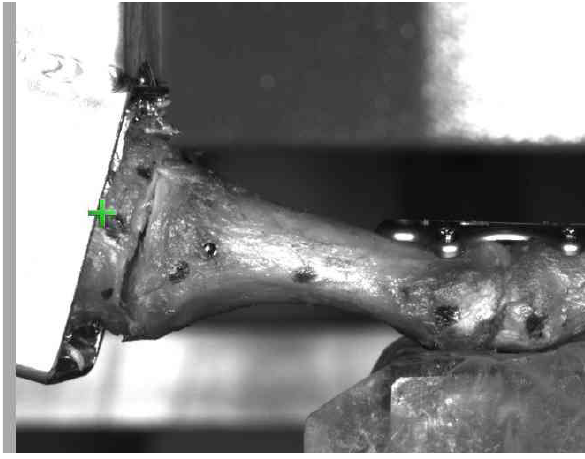
Fig. 11. Joint gapping in specimen 6 after application of 30N force, PS